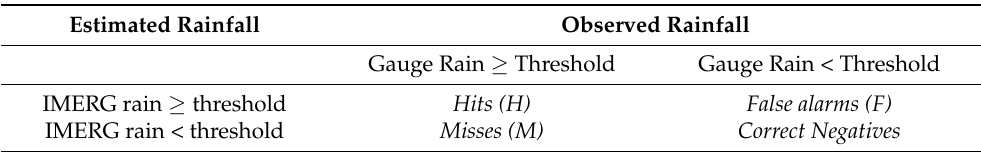
Table 1. Contingency table for comparing rainfall observed by XEMA and estimated by IMERG for a given threshold.